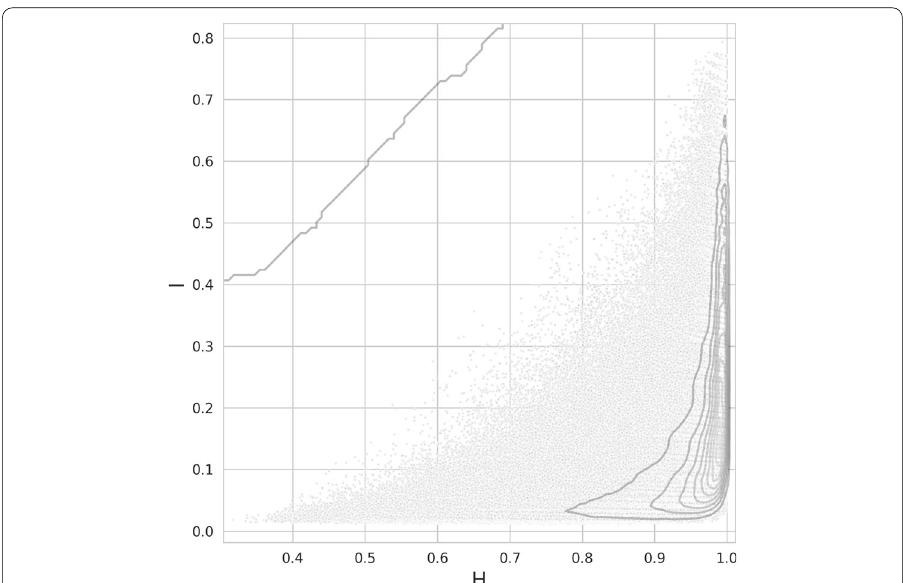
Fig. 7 Homogeneity and intensity H × I on 1,329,696 synthetic multiplex networks without transition coupling with density lines (Gaussian kernel density